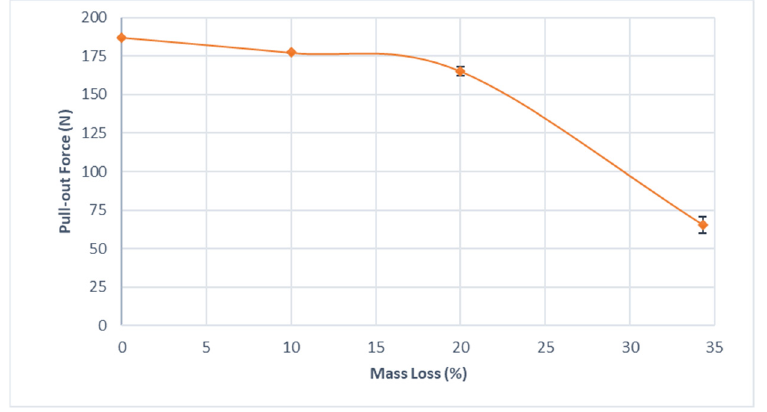
Figure 17. Pull-out force vs. mass loss. The error bars represent the standard deviation from the mean (n = 3).